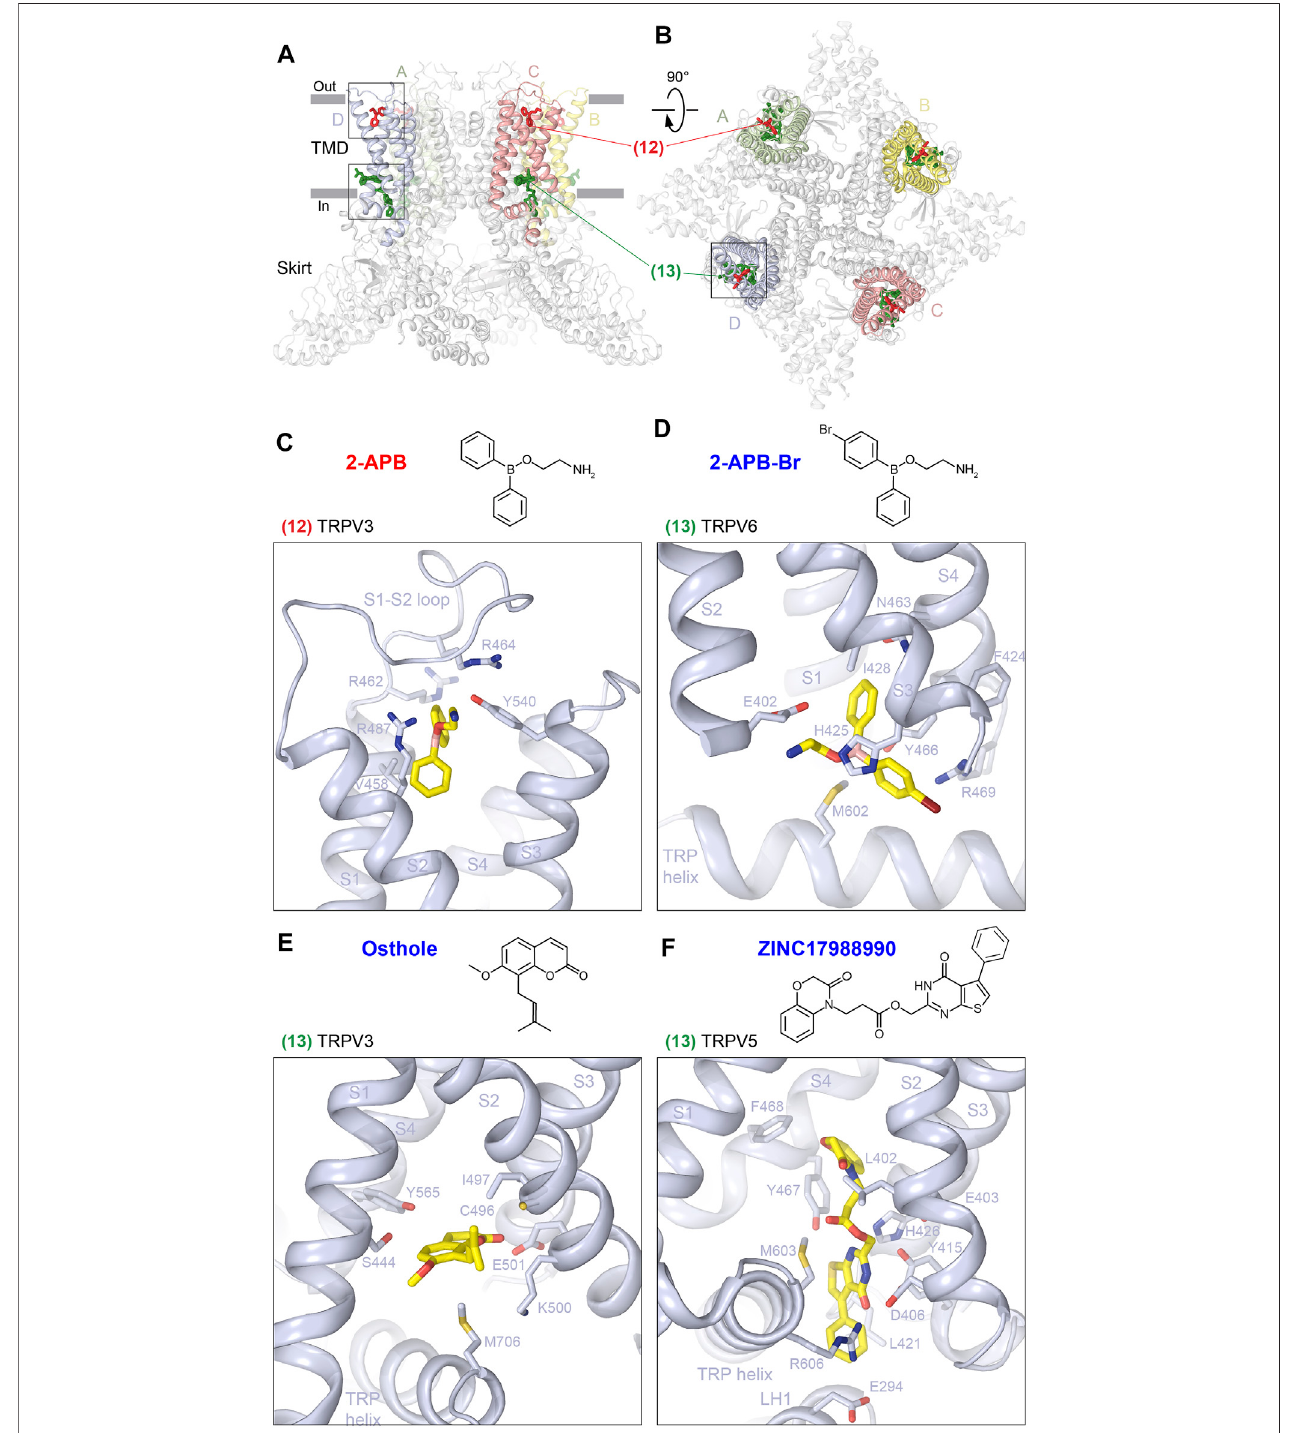
FIGURE 6 | S1-S4 sites. (A – B) , Side (A) and top (B) views of the TRPV1 tetramer (gray; PDB ID: 7LQY) with the S1-S4 top (12) and base (13) sites illustrated by ligands in red and green, respectively. Rectangles indicate the regions expanded in close-up views. (C – F) Close-up views of the S1-S4 top site in TRPV3 with bound 2- APB ( C , PDB ID: 6DVZ) and S1-S4 base site in TRPV6 with bound 2-APB-Br ( D , PDB ID: 6D7V), in TRPV3 with bound osthole ( E , PDB ID: 7RAS), and in TRPV5 with bound ZINC17988990 ( F , PDB ID: 6PBE). Residues contributing to ligand binding are shown in sticks. The chemical structures of the corresponding ligands are shown above the close-up